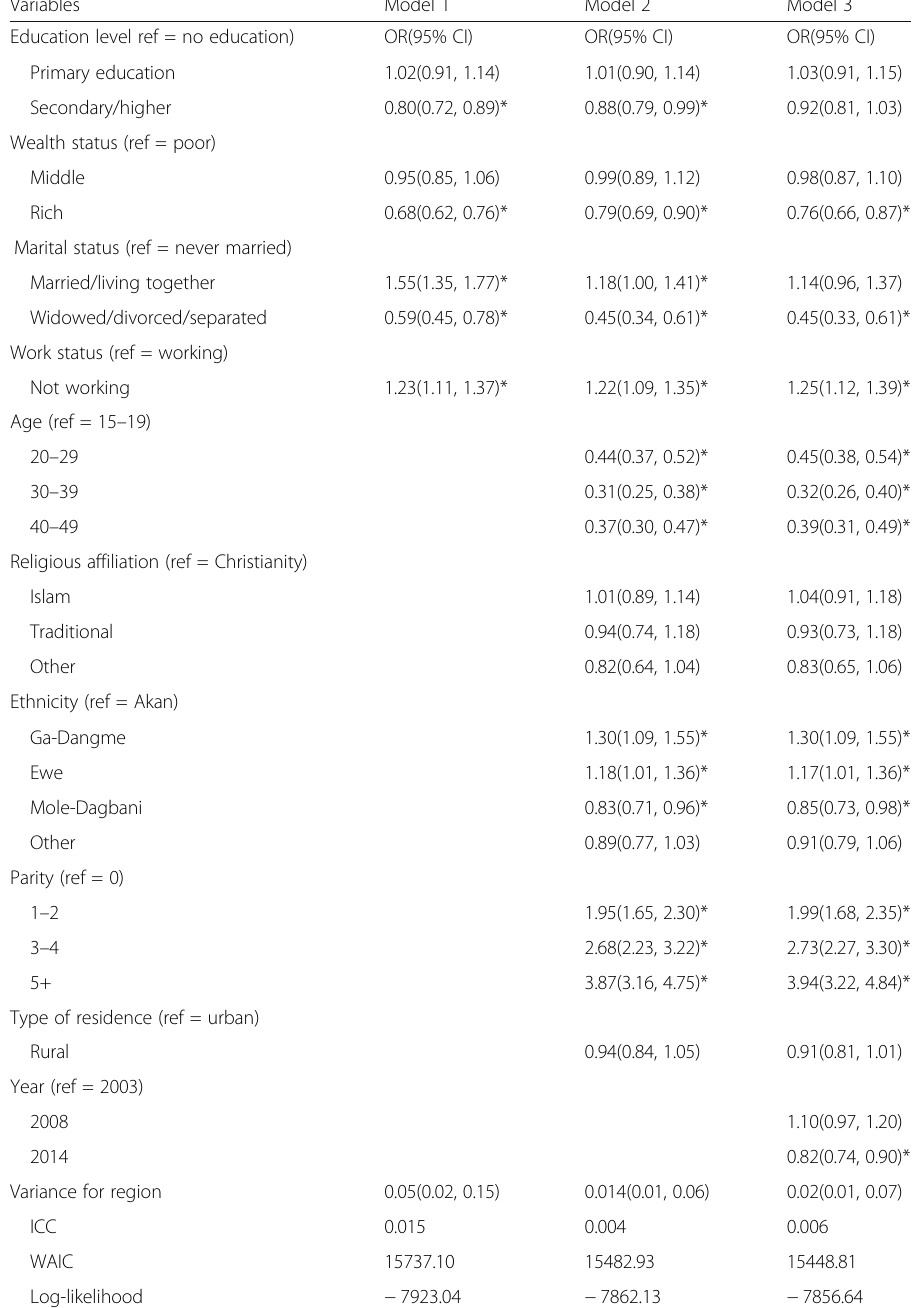
Table 3 Multilevel logistic regression models of unmet need among women in Ghana Variables Model 1 Model 2 Model